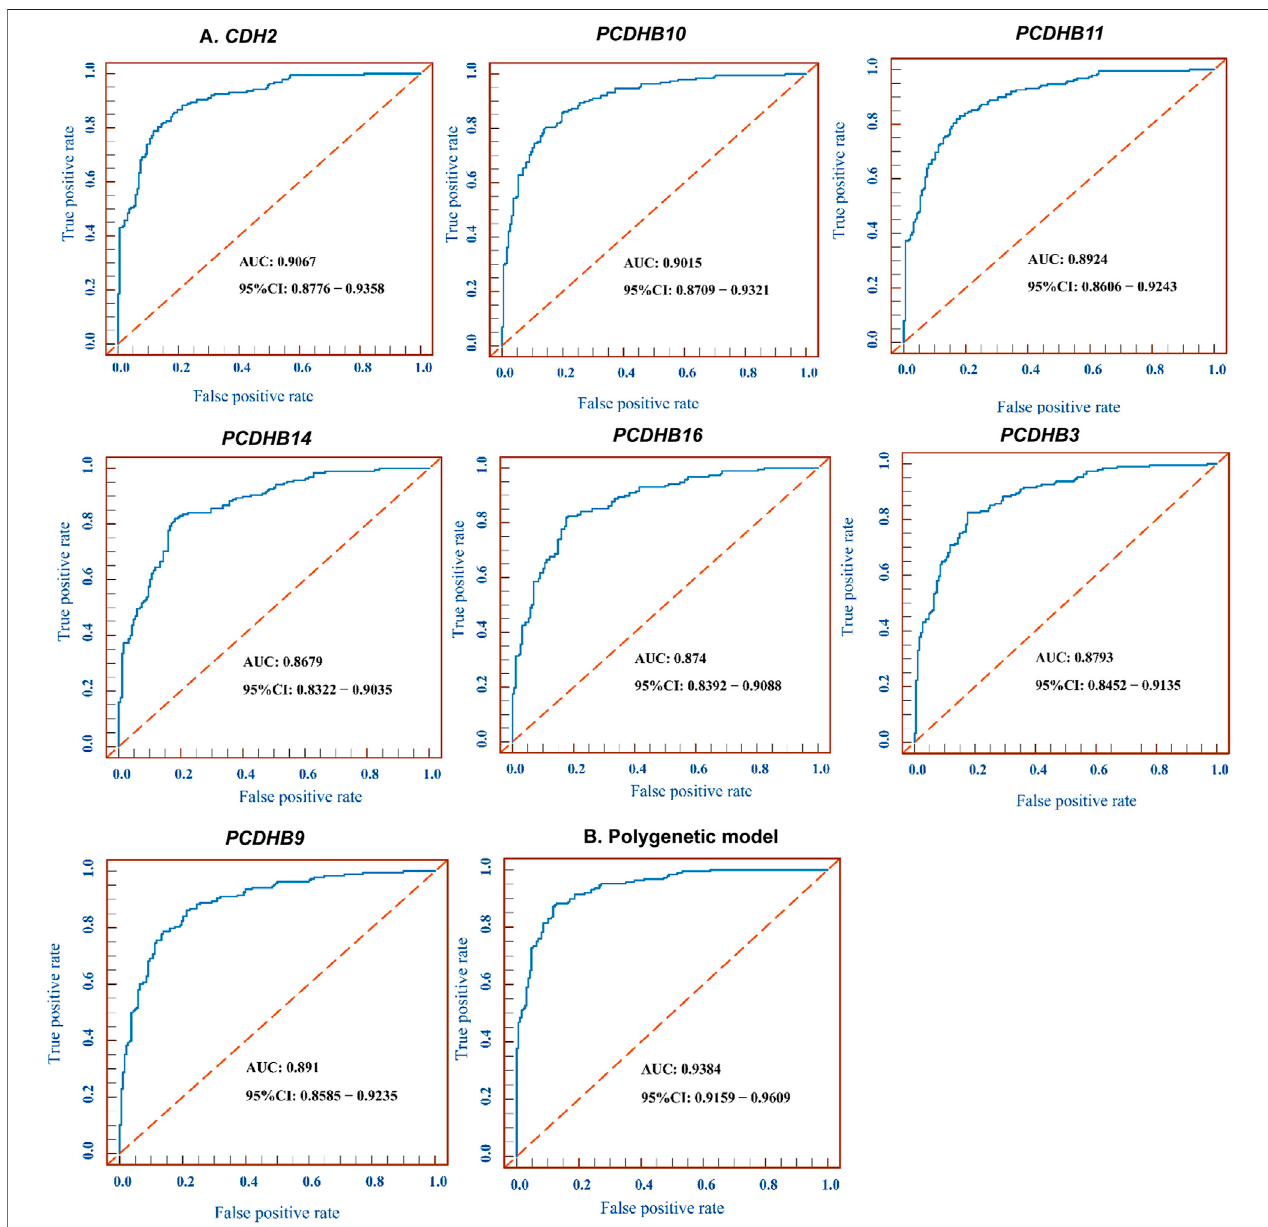
FIGURE 4 | ROC for 7 differentially methylated genes and polygenic methylation model. (A) ROC curve measuring sensitivity ( Y axis) and 1-speci fi city ( X axis) of methylation of CDH2/PCDHB10/PCDHB11/PCDHB14/PCDHB16/PCDHB3/PCDHB9 genes as biomarkers for discriminating IS from controls. (B) ROC curve of the polygenic methylation model. AUC, area under the curve; ROC, receiver operating characteristic; CI, con fi dence interval.